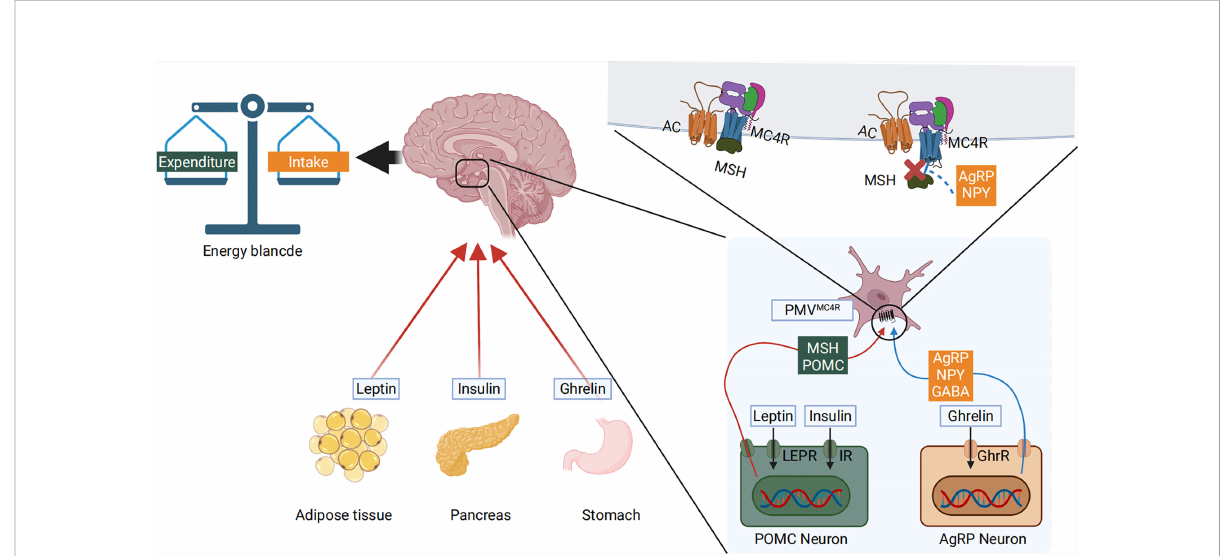
FIGURE 2 Peripheral blood nutrient concentrations and hormones constitute the peripheral energy state signals. High blood glucose levels cause pancreatic islets to produce insulin and adipose tissue to produce leptin. The low nutritional state and energy status allow the stomach to produce ghrelin. These molecules are transmitted to the hypothalamic center, where the melanocortin system responds to these signals. The LEPR and GHER receptors are expressed on the cell surface membrane of AgRP and POMC neurons. The hormones bind to their respective receptors, activating the pomc and agrp genes that are transcribed, producing a -MSH and AgRP. a -MSH further interacts with MC4R to reduce food intake. Conversely, when AgRP is produced, it directly blocks a -MSH mediated activation of the MC4R, thus inhibiting a -MSH ’ s action and increasing food